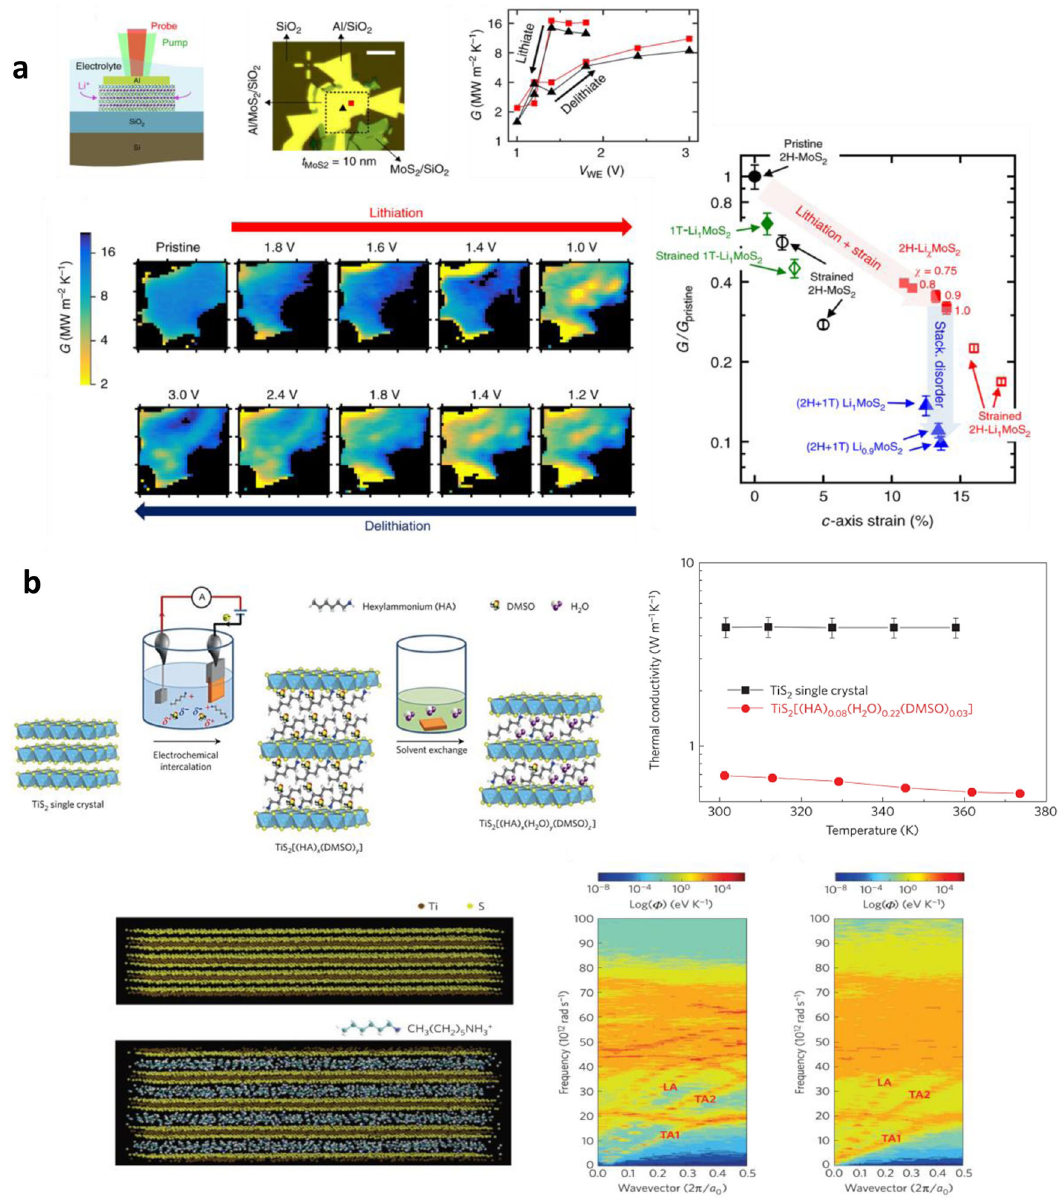
Fig. 8 Intercalation effects on MoS 2 and TiS 2 . a Thermal conductance of MoS 2 tuned by electrochemical Li-intercalation. Schematic illustration of cross-sectional view and optical micrograph of the 10 nm thick MoS 2 device used for operando scanning thermal conductance measurements (top-left and center). Thermal conductance vs. voltage measured for this structure (top-right). Thermal conductance maps taken at different stages of lithiation and delithiation over one electrochemical cycle. (bottom). Calculations of the normalized cross-plane thermal conductance of a 10 nm thick MoS 2 fi lm plotted vs. % c -axis strain (%) relative to the pristine (unlithiated) 2H-MoS 2 (right) 207 . b Synthesis and thermal properties of TiS 2 -based inorganic/organic TiS 2 [(HA) x (H 2 O) y (DMSO) z ] superlattices. Schematic illustration of the synthesis process (top-left). In-plane thermal conductivity measured as a function of temperature for TiS 2 single crystal and TiS 2 [(HA) 0.08 (H 2 O) 0.22 (DMSO) 0.03 ] hybrid superlattice (top-right). Structural model of TiS 2 single crystal and TiS 2 [(HA) 0.08 (H 2 O) 0.22 (DMSO) 0.03 ] hybrid superlattice (bottom-left). Spectral energy density for bulk TiS 2 single crystal and the TiS 2 monolayer in the TiS 2 [(HA) 0.08